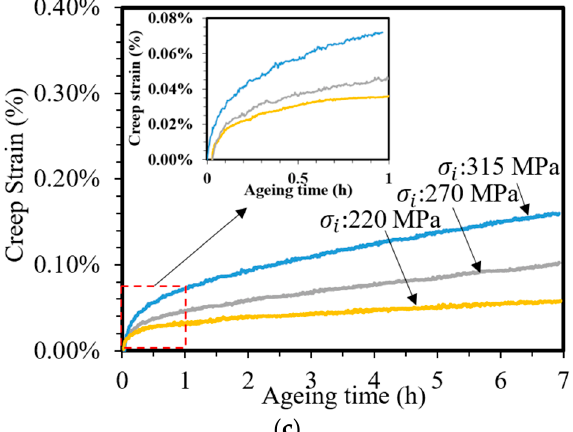
Figure 3. ( a ) Creep and ( b ) stress relaxation curves of 7050 aluminum alloy with various stress levels during ageing at 177 °C. ( c ) The creep strains extracted from the stress relaxation curves in ( b ) were calculated using Equation (2). Note that σ and σ i represent the stress and initial stress levels during creep and stress relaxation tests, respectively.